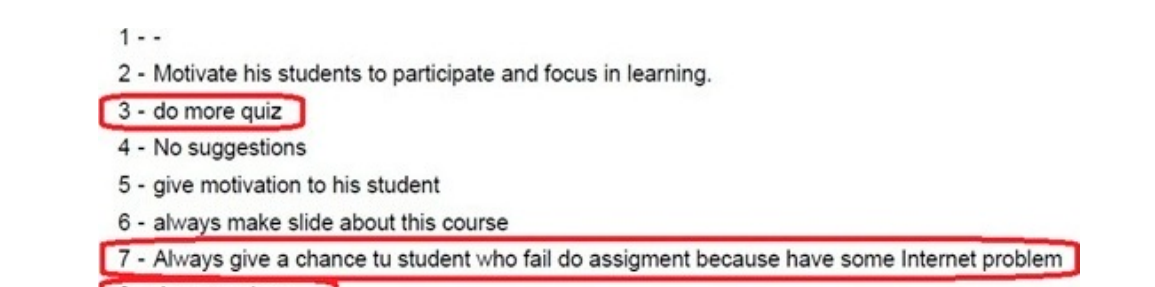
Figure 1. Screenshot (1) of highlighted students’ comments .